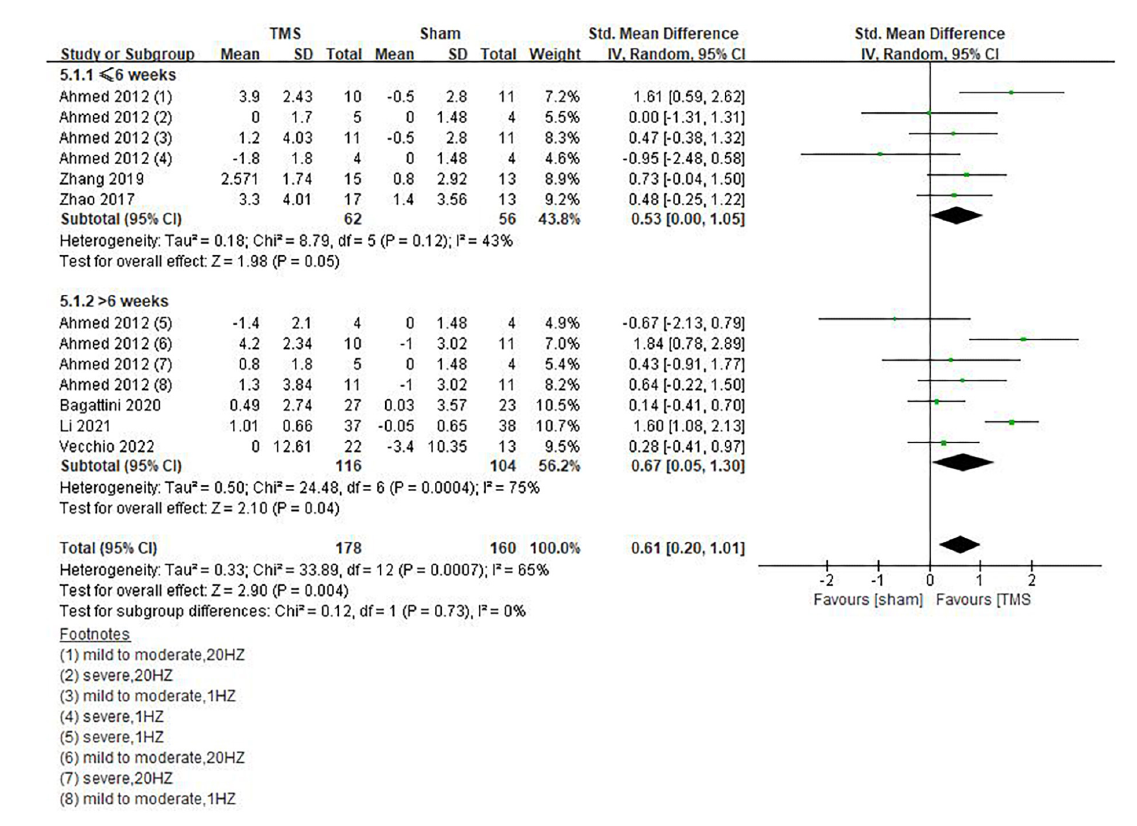
FIGURE8 Post-treatment effects of repetitive transcranial magnetic stimulation (rTMS) on global cognitive functions.